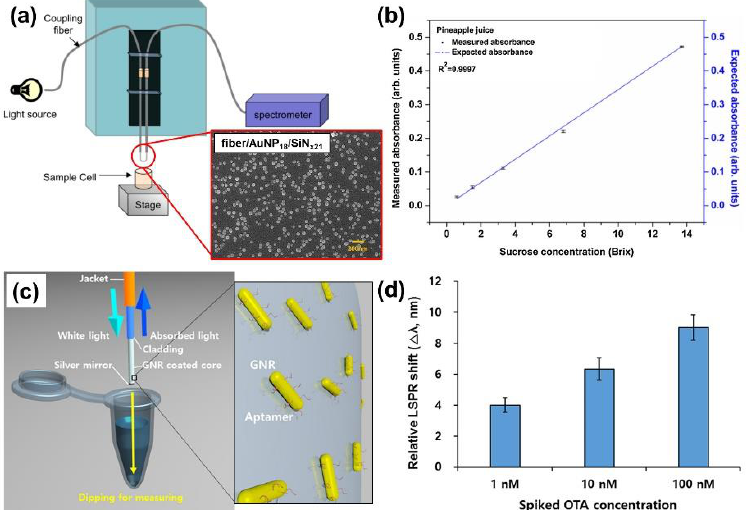
Figure 13. Fiber-optic LSPR sensors for food safety and assessment. ( a ) Schematic of a fiber-optic probe integrated with gold nanoparticles deposited on a silicon nitride substrate for measuring sucrose (sugar) content in fruit juices. ( b ) Absorbance of various sucrose concentrations in commercial pineapple juice measured by the fiber-optic LSPR sensor. The figures in Chauhan et al. [113] are reprinted with permission from Elsevier. ( c ) Schematic of a fiber-optic LSPR sensor based on the integration of colloidal, aptamer-modified nanoparticles for the measurement of ochratoxin A. ( d ) Spectral shifts of LSPR peak wavelengths with different concentrations of ochratoxin A in 50% grape juice. The reprint of the figures in Lee et al. [115] was permitted by